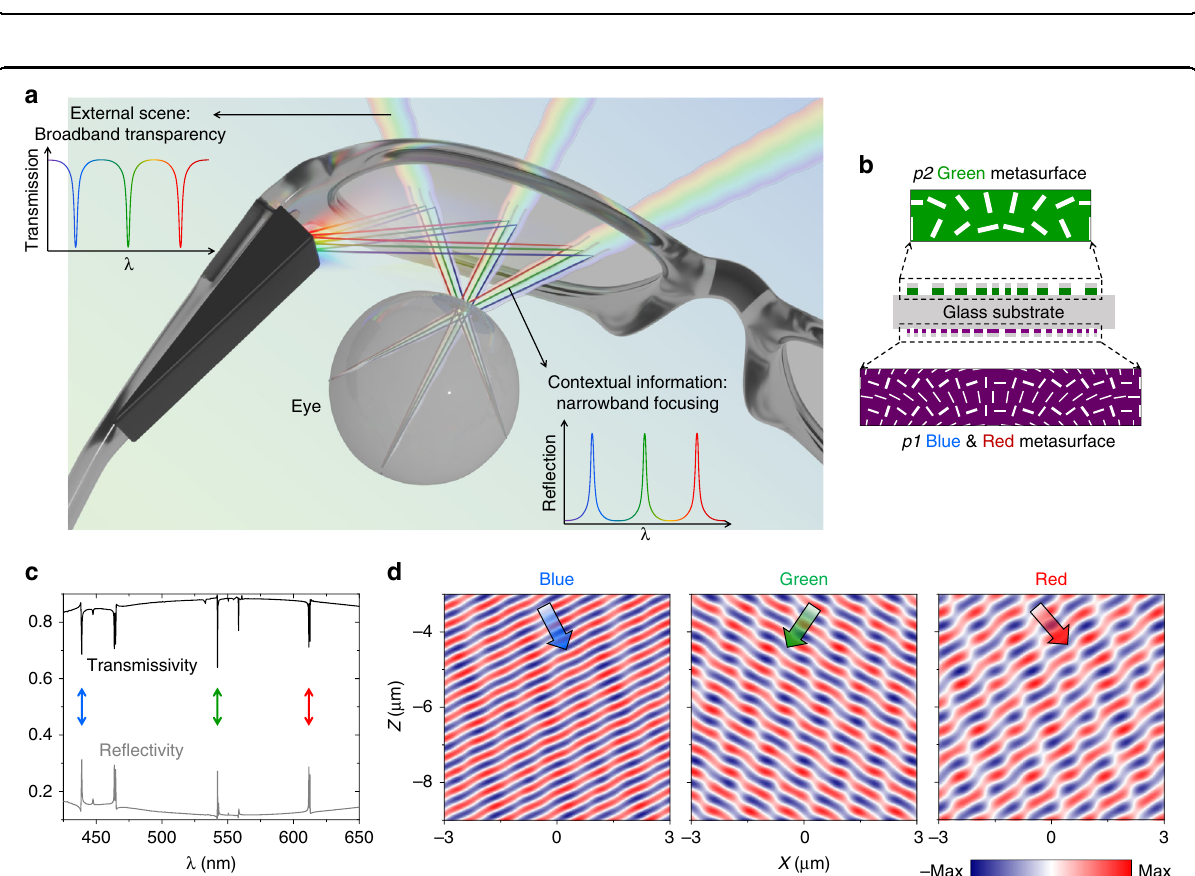
Fig. 6 Conceptual demonstration of AR enabled by multifunctional nonlocal metasurfaces. a Illustration showing the operation of an AR headset with multifunctional nonlocal metasurfaces as optical see-through lenses. b Schematic of a super-period of a nonlocal meta-optics system implementing three distinct phase gradients at three chosen visible wavelengths, respectively. See Table S1 for detailed design parameters. c Simulated transmission and re fl ection spectra of the meta-optics system. Arrows indicate three TE q-BICs for wavefront shaping at the three colors. Additional spectral features correspond to TM modes associated with the chosen TE modes or result from subtle symmetry-breaking introduced by meshing during full-wave simulations. d Simulated re fl ected wavefronts shaped by independent q-BICs at λ B = 439 nm, λ G = 542 nm, and λ = 612 nm. Arrows indicate light propagation directions at the three R